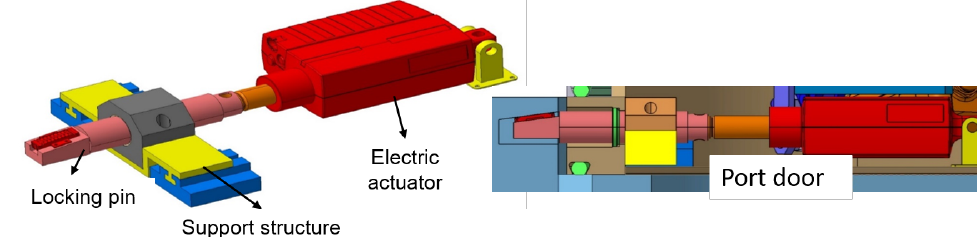
Figure 8. The locking mechanism between the port door and